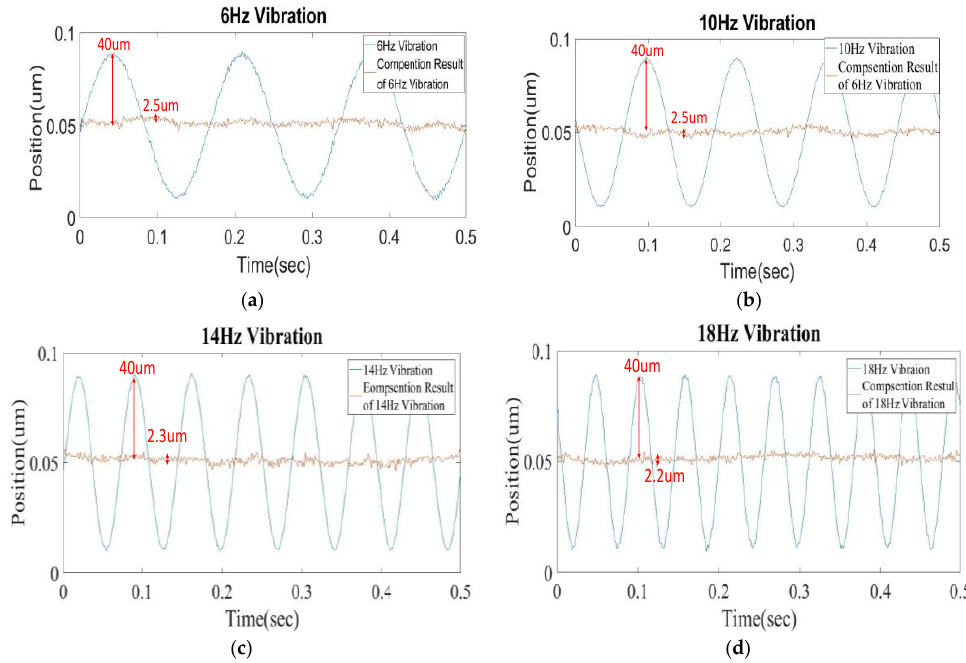
Figure 11. Measured motions of the controlled lens holder with external disturbances programmed by the shaker to mimic major harmonics of a typical hand-shaking disturbance along x -direction; ( a ) External disturbance at 6 Hz; ( b ) External disturbance at 10 Hz; ( c ) External disturbance at 14 Hz; ( d ) External disturbance at 18 Hz.